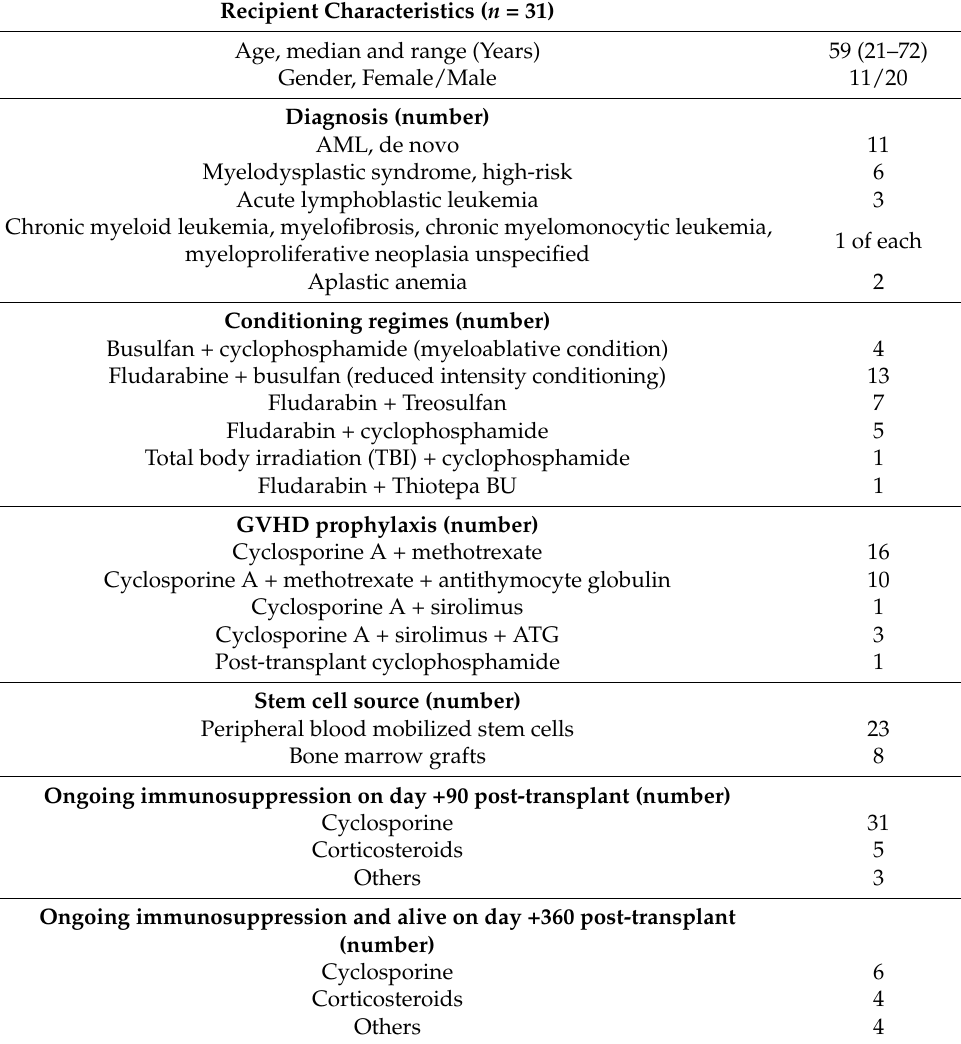
Table 1. The characteristics of the allotransplant recipients and their donors included in the analysis. Recipient Characteristics ( n =